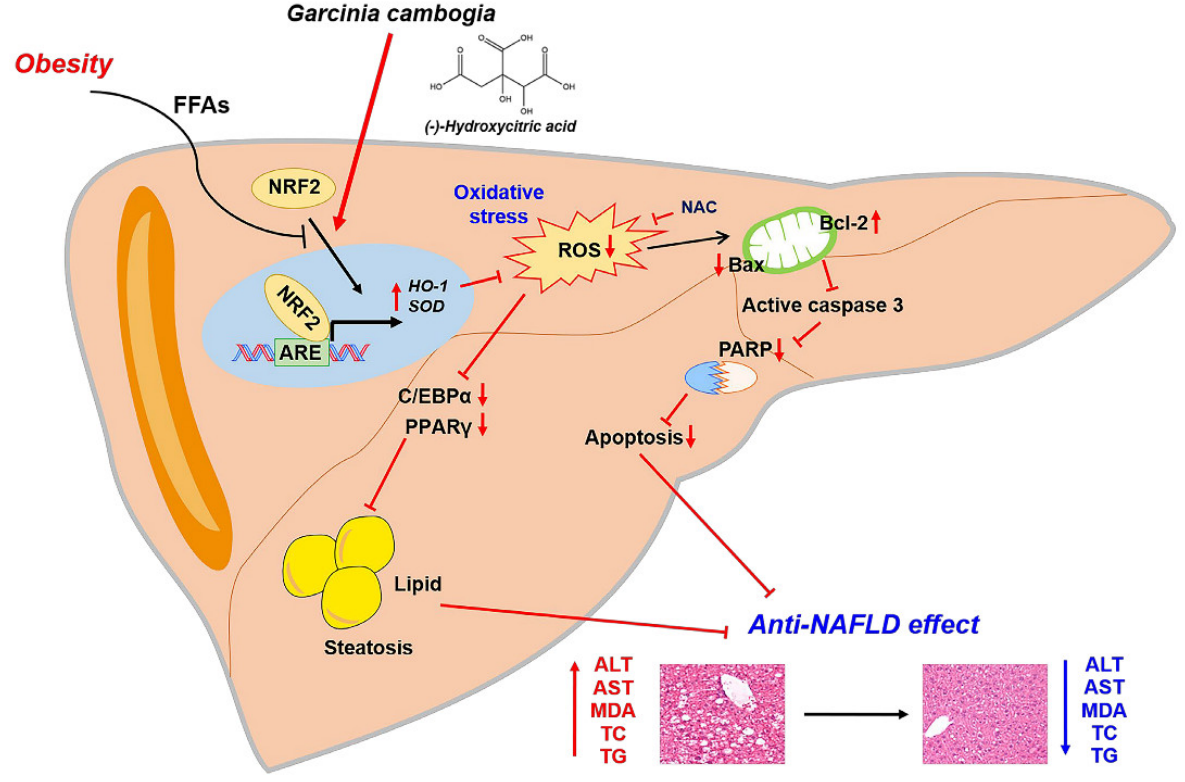
Figure 6. Proposed mechanism of the protective effect of G. cambogia against NAFLD. G. cambogia inhibited HFD-induced NAFLD by activating the NRF2-ARE-mediated antioxidant defense system, leading to inhibition of hepatic steatosis and apoptosis in the liver.